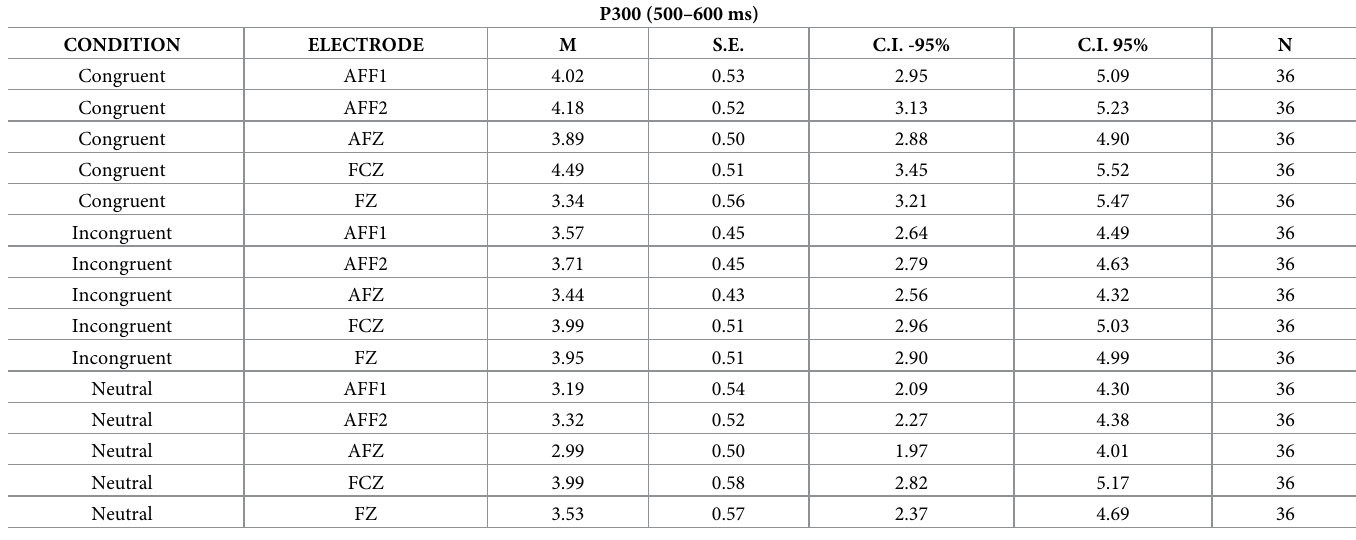
swLORETA source reconstruction The swLORETA inverse solution, applied to the Difference Waves obtained by subtracting ERP waveforms elicited by Congruent from that elicited by Incongruent stimuli in the Table 3. P300 mean amplitude values recorded in the 500–600 ms time window in response to congruent, incongruent, and neutral terminal words, at anterior and front-central sites (AFF1, AFF2, AFZ, FCZ,